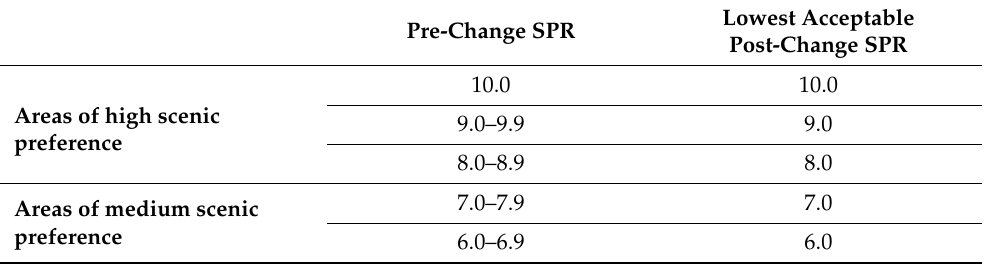
Table 3. Acceptable level of